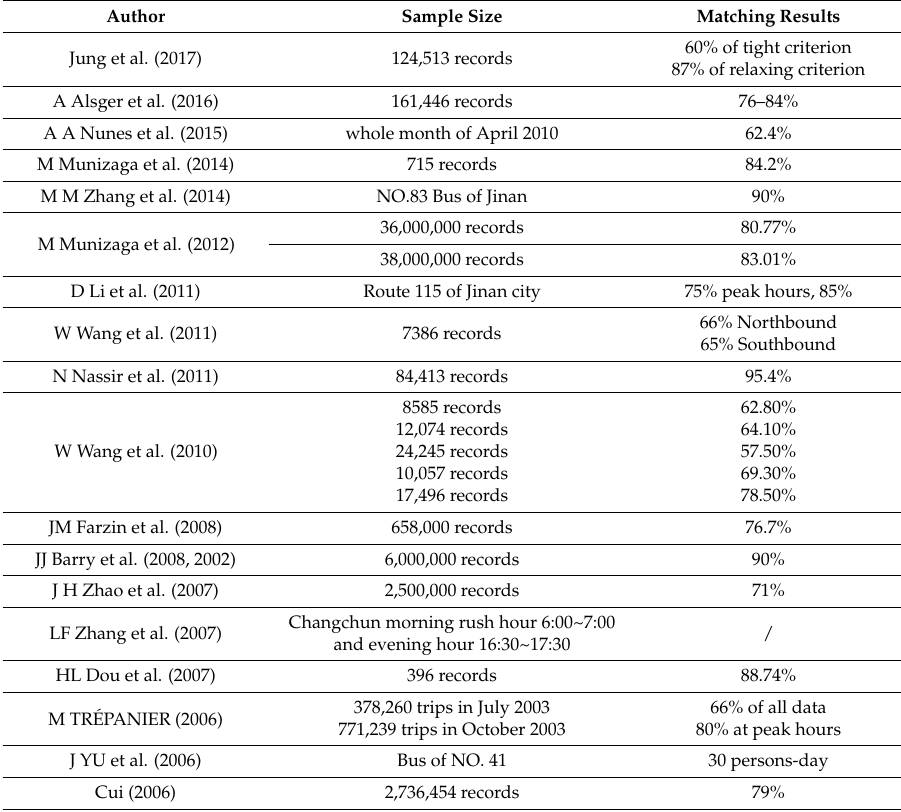
Table 6. Comparison of sample size and matching